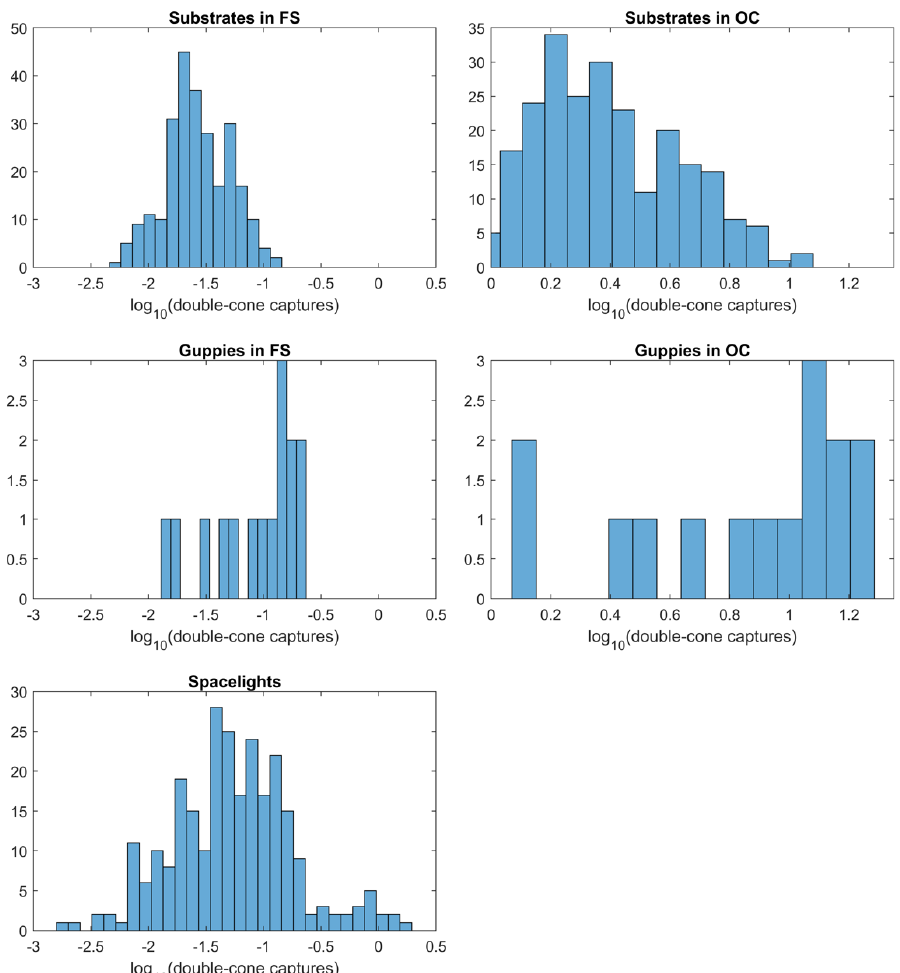
Figure 4. Distribution of luminance or achromatic (double cone) quantum captures for substrates, guppy patches and spacelight, after the von Kries correction. Note the very different horizontal scales for Forest Shade ( FS ) and Cloudy ( OC ) and between spacelight and OC data. This is because FS light is about 100 times less intense than OC